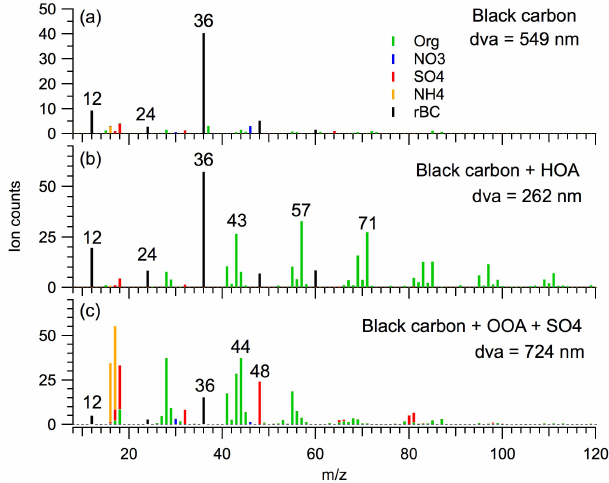
Figure 6. Examples of single particle mass spectra of rBC- containing particles in ambient air: (a) black carbon, (b) black car- bon internally mixed with HOA, and (c) black carbon internally mixed with OOA and sulfate. Particles (a) and (b) are sorted into the rBC cluster, and particle (c) is classified into the OOA cluster 2 identified in this study (see Sect.